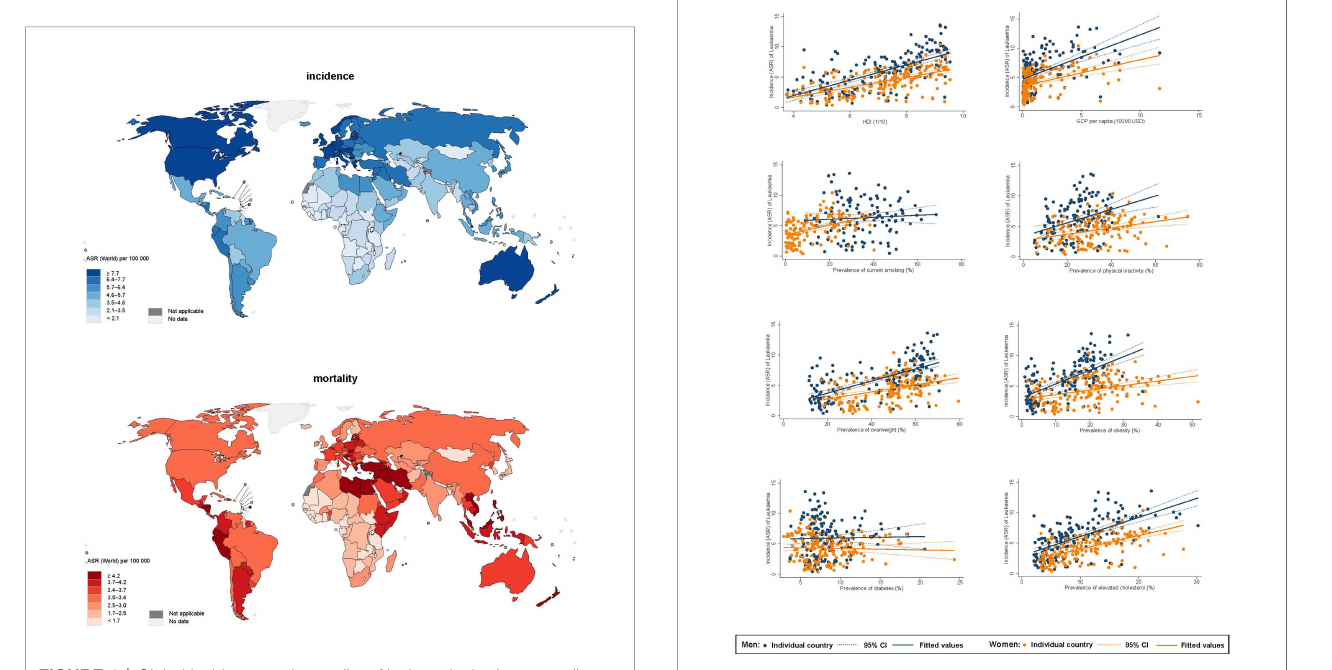
FIGURE 1 | Global incidence and mortality of leukaemia, both sexes, all ages, in 2020. FIGURE 2 | Associations between risk factors and incidence of